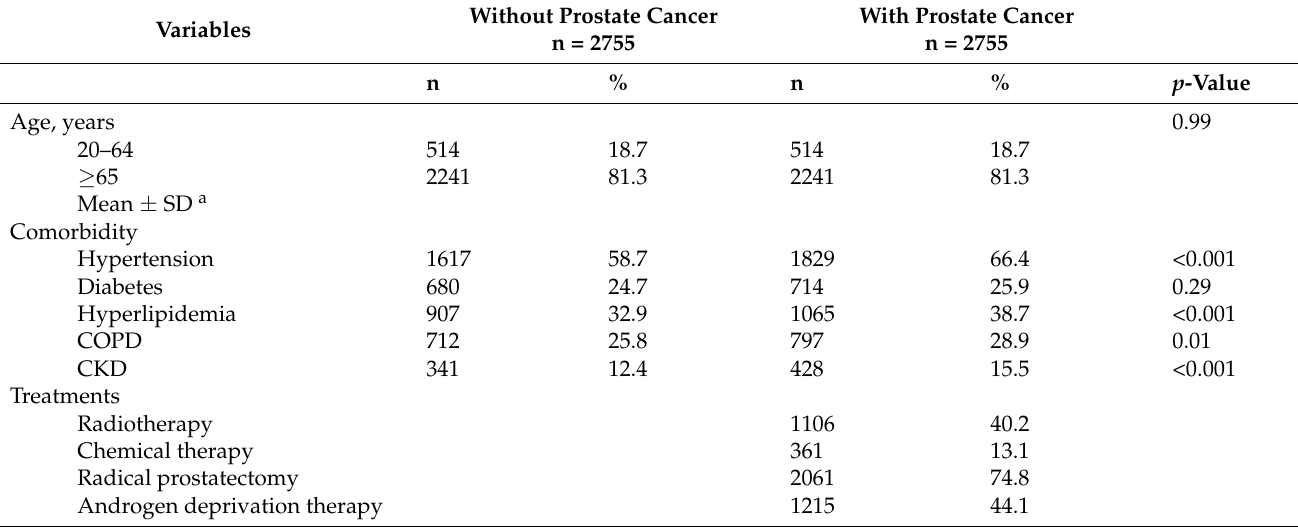
Table 1. Baseline characteristics of the patients with or without prostate